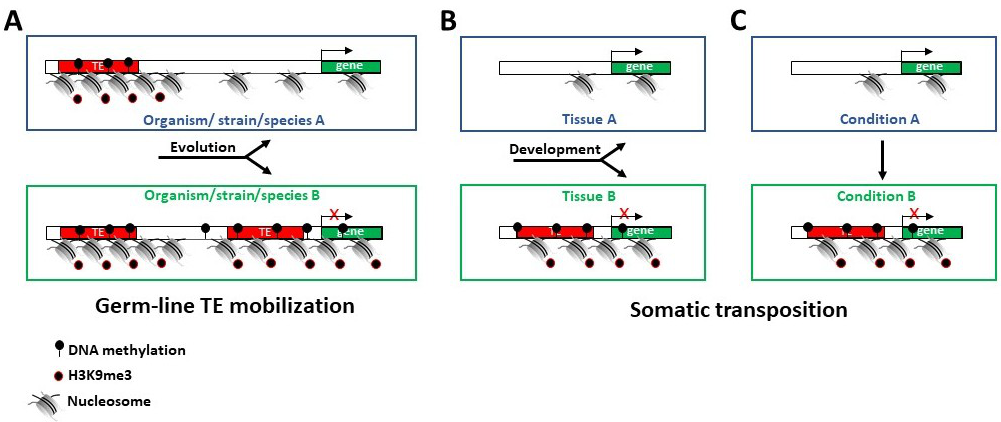
Figure 1. Effect of TE localization on the epigenetic regulation of gene expression. ( A ) The different distribution of TEs during evolution reshapes the epigenetic regulation of a specific gene. ( B ) The differential redistribution of TEs in different cells/tissues of the same organism during the development affects the expression of a specific gene. ( C ) The relocalization of TEs sequence in the same cell after a specific stimulus/condition affects the expression of a specific gene.